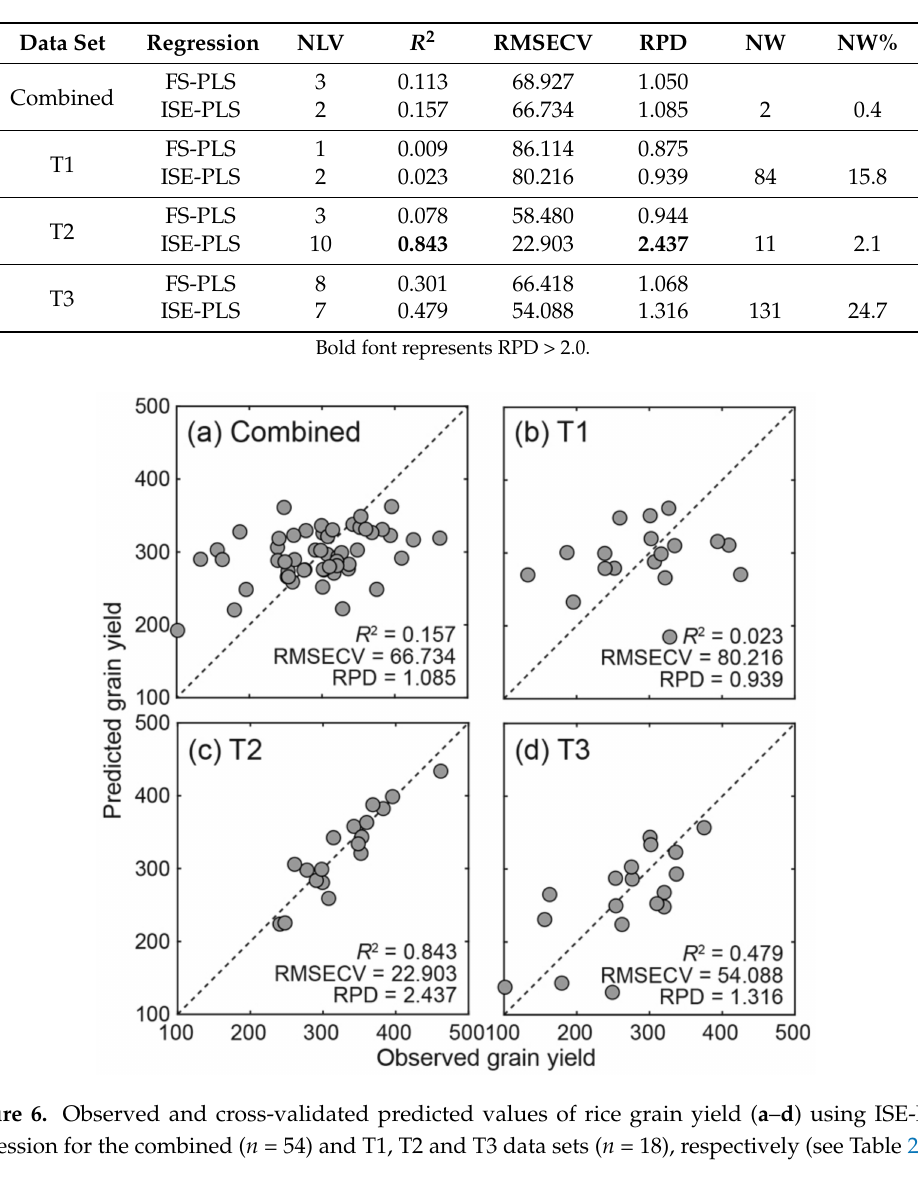
Table 2. Optimum number of latent variables (NLV), coefficient of determination ( R 2 ), root mean squared errors of cross-validation (RMSECV), and residual predictive values (RPD) from full-spectrum partial least squares (FS-PLS) and iterative stepwise elimination PLS (ISE-PLS) models with a selected number of wavebands (NW) and their percentages of the full spectrum (NW%).